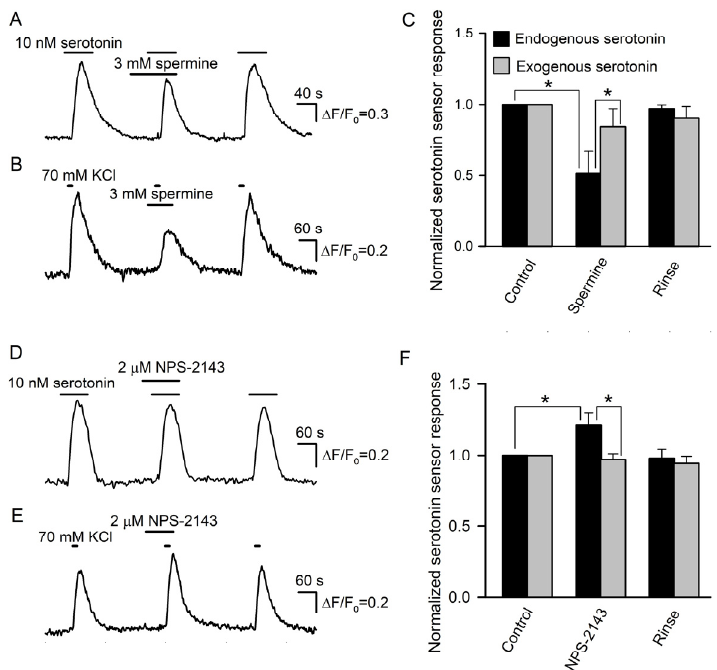
Figure 7. Effects of CASR ligands on biosensor responsivity and serotonin release. ( A ) Serotonin sensor responses in control, in the presence of 3 mM spermine, and after its rinse. ( B ) Effect of 3 mM spermine on depolarization-induced serotonin release assayed as in Figure 4A. ( C ) Averaged serotonin sensor responses to serotonin, either endogenously released from taste buds ( n = 15) (black bars) or externally applied at 10 nM ( n = 56) (gray bars), in control, in the presence of 3 mM spermine, and after its rinse. In each particular recording, the first control response was taken as a unit. The data are presented as the mean ± S.D. ( D ) NPS-2143 (2 μ M) subtly affected serotonin sensor responsivity to exogenous serotonin applied at 10 nM. ( E ) Biosensor response to serotonin released from a taste bud was enhanced in the presence of 2 μ M NPS-2143. ( F ) Averaged serotonin sensor responses to serotonin, either endogenously released from taste buds ( n = 14) (black bars) or externally applied at 10 nM ( n = 48) (gray bars), in control, in the presence of 3 mM spermine, and after its rinse. The data are presented as the mean ± S.D. In all cases, the asterisk means statistically representative difference ( p = 0.001).